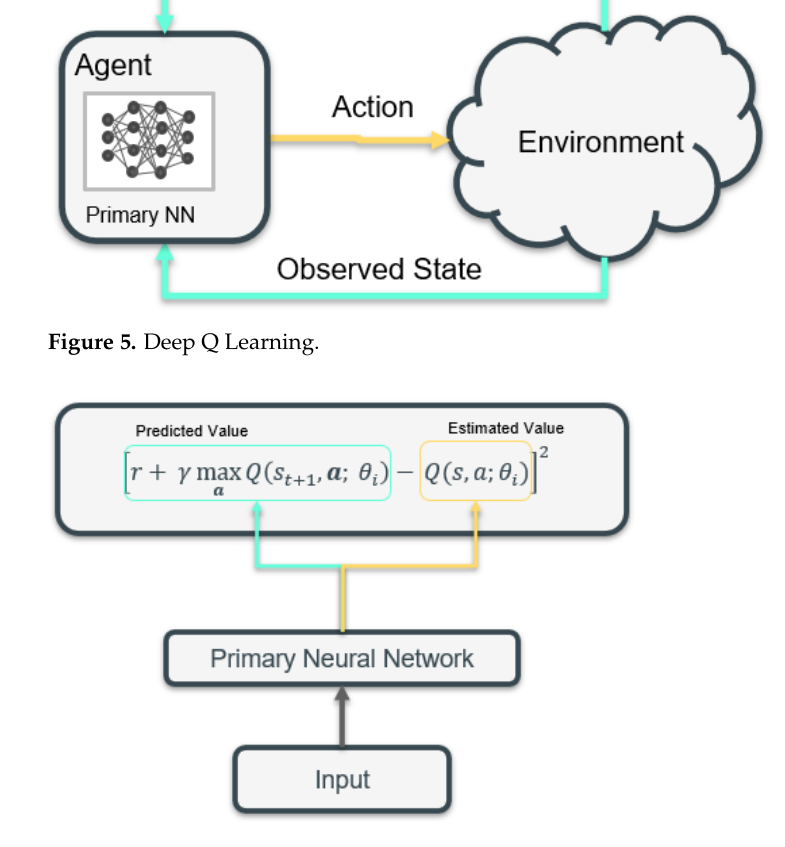
Figure 6. Correlation between Q and Target